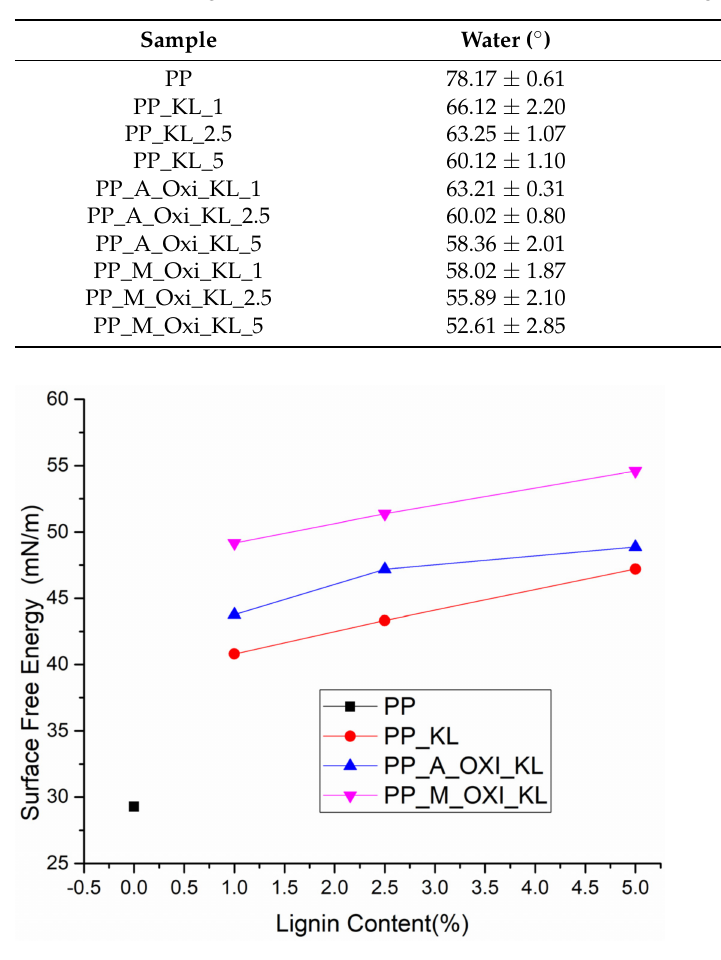
Figure 6. Calculated surface energies of the PP and PP-lignin films. The surface free energy of the PP film without any lignin is represented as a black line for all lignin content % for comparison